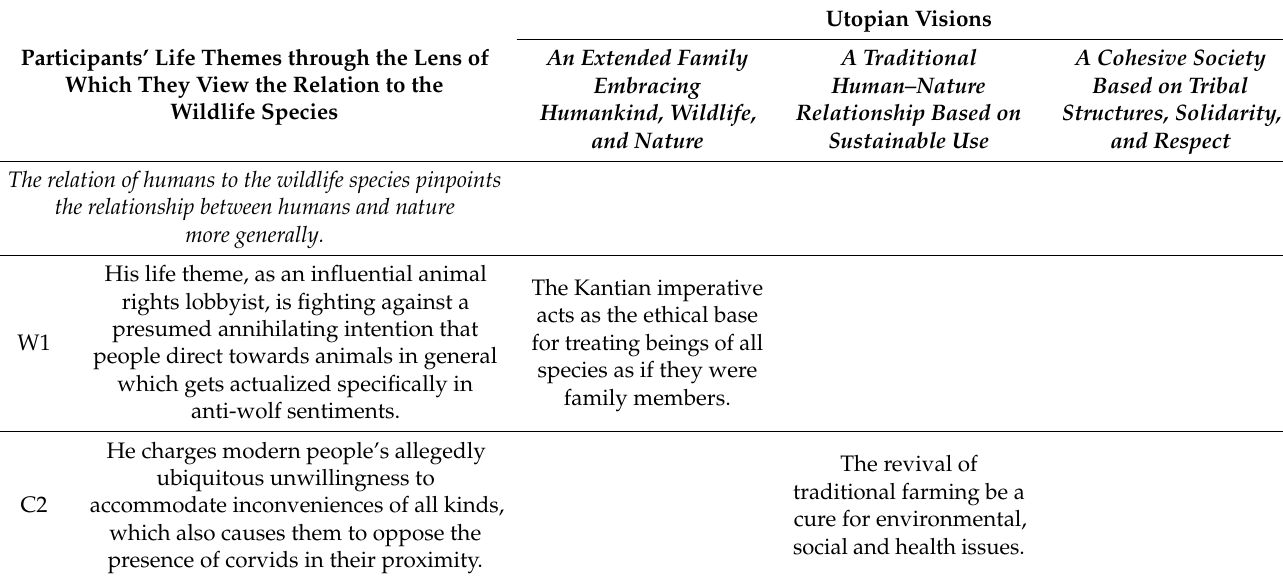
Table 1. Participants’ life themes within which their relations to the respective model animals, and their utopian visions that include ideals for managing wildlife, are embedded. “~” denotes that for a given subject a clear inclination for a particular theme or vision can be inferred from the context and tone of the interview yet was not explicitly